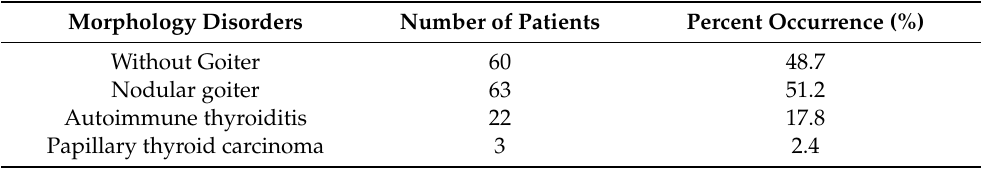
Table 3. Frequency of thyroid morphology disorders among the